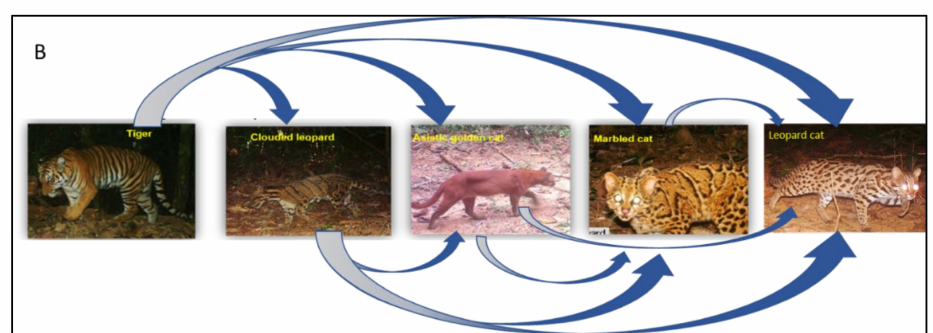
Figure 1. ( A ) Proposed hypotheses of spatio-temporal interaction among felid species (where TG = Tiger, CL = Clouded leopard, GC = Asiatic golden cat, MC = Marbled cat, LC = Leopard cat, and H = Hypothesis. The size of overlap of circles (Orange colour) represents greater or lesser spatio- temporal overlap between two species). ( B ) Proposed model of spatio-temporal influence of larger cats on smaller cat (from left to right: tiger ( Panthera tigris ), clouded leopard ( Neofelis nebulosa ), Asiatic golden cat ( Catopuma teminckii ), marbled cat ( Pardofelis marmorata ), and leopard cat ( Prionailurus bengalensis )) (photos not to